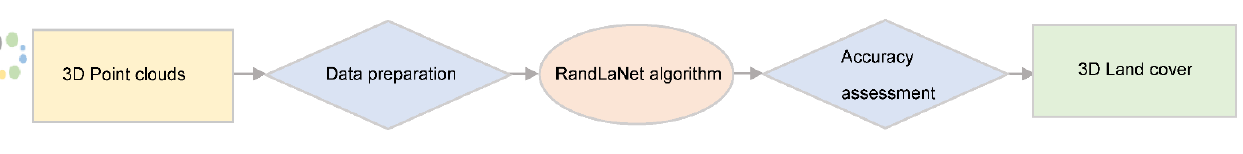
Figure 7. The general workflow of the non-fusion approach.